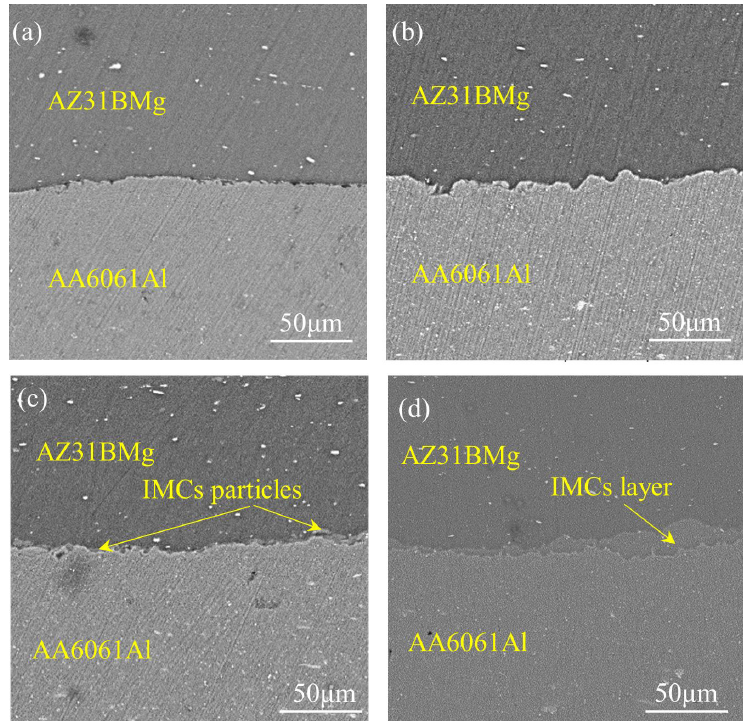
Figure 4. Microstructures of welded joints (a) 700 J (b) 980 J (c) 1260 J (d) 1540 J.